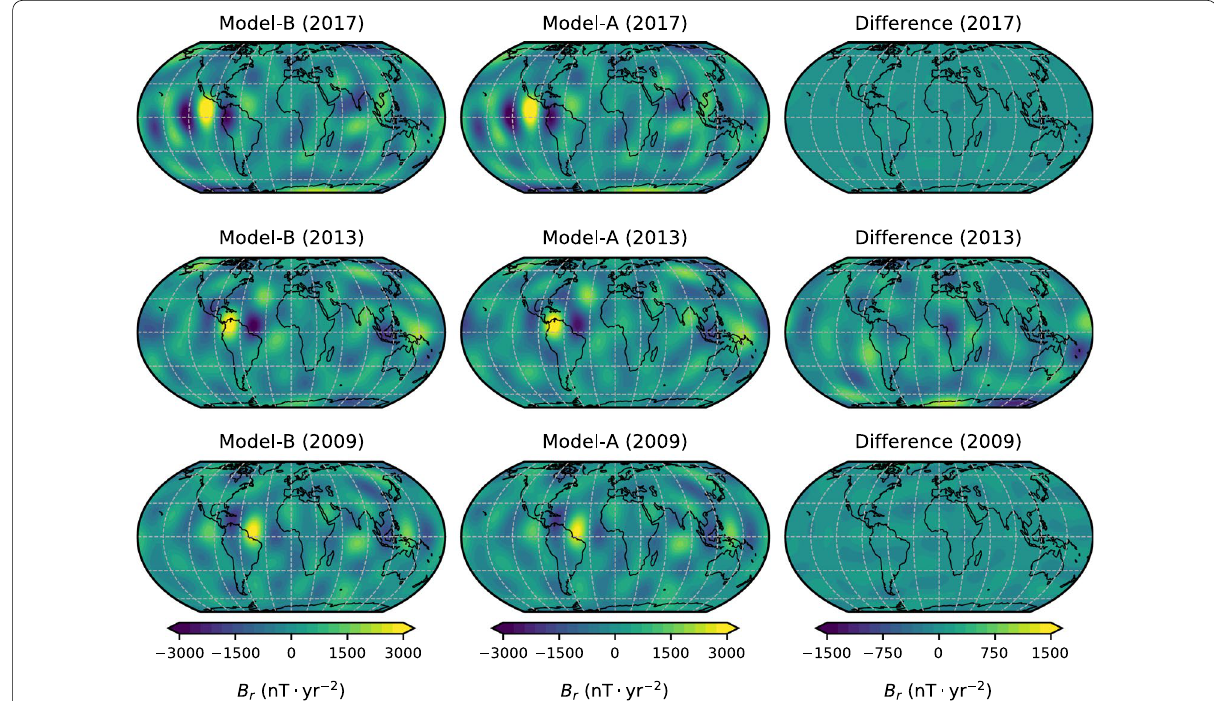
Fig. 10 Global maps of the radial SA up to degree 10 at the CMB for Model-B (left column), Model-A (center column), and the difference (right column). The maps are computed in 2009 (bottom row), 2013 (center row), and 2017 (top row). The projection is Equal Earth (Šavrič et al.